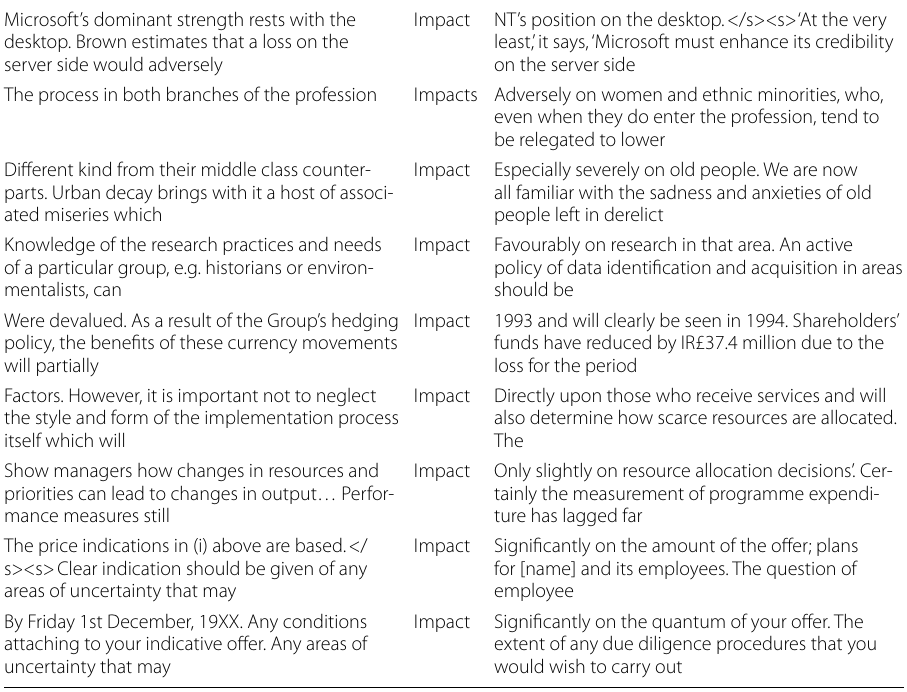
Table 5 Examples of concordance lines of impact adverbial collocates Microsoft’s dominant strength rests with the desktop. Brown estimates that a loss on